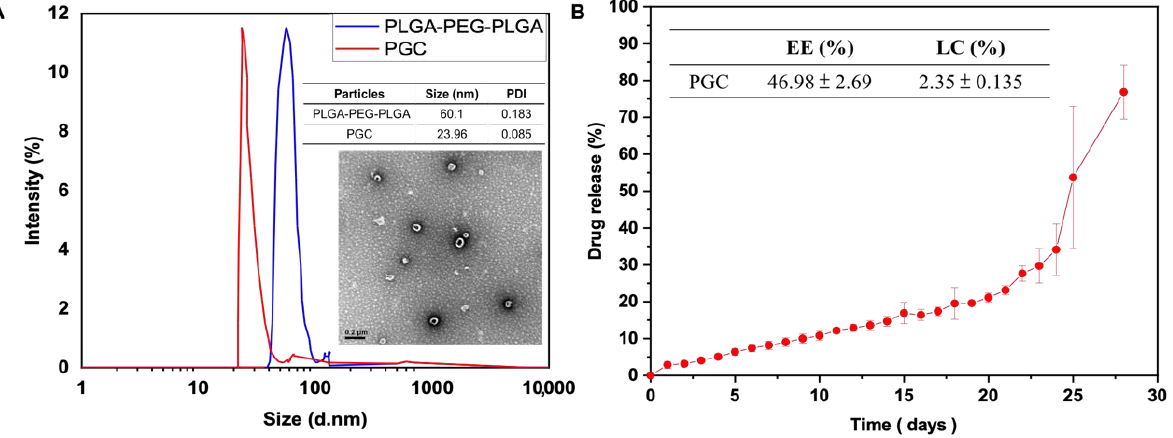
Figure 2. Morphology of micelles, particle size identification, drug loading efficiency, and drug re- lease profile. ( A ) The identification and morphology of particles and ( B ) the loading efficiency and drug release profile.